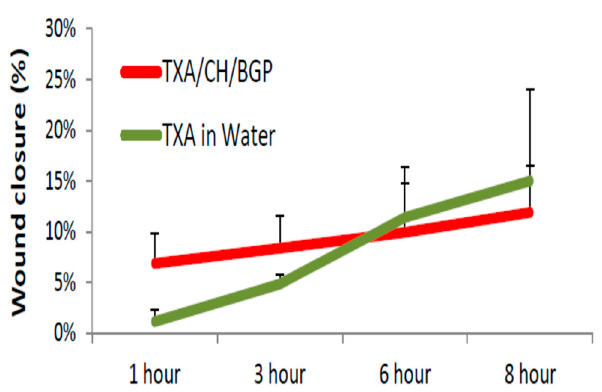
Figure 19. In vitro cell migration (expressed as % closure of the gap versus time) in scratched nasal epithelium cell layer: (red) formulation, (green) control.